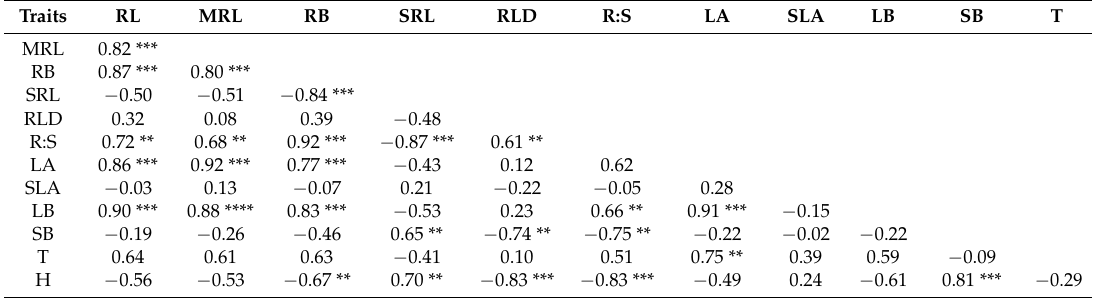
Table 5. Pearson correlations ( r ) between 12 traits investigated in wheat cultivars. RL = root length; MRL = mapped root length; RB = root biomass; SRL = specific root length; RLD = root length